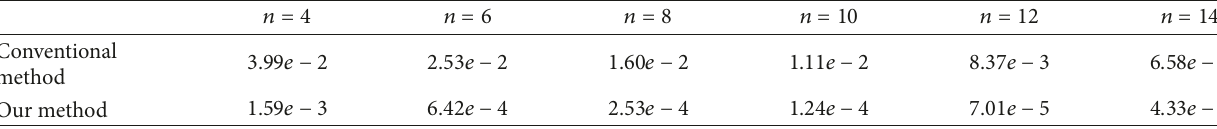
Table 1: The comparison of numerical results of the two